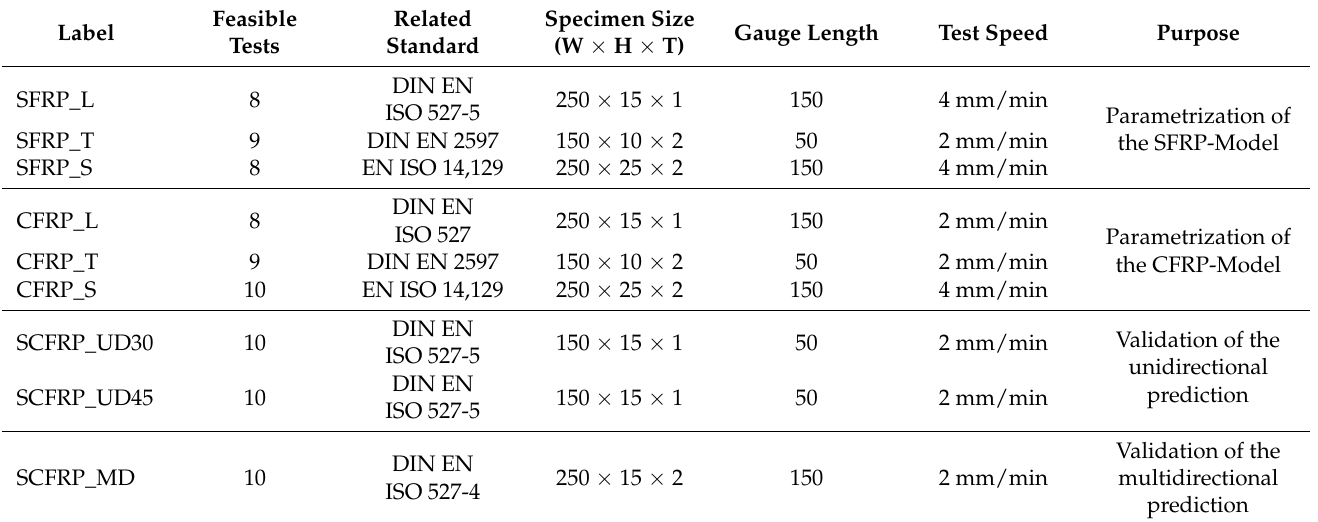
Table 2. Scope of testing as well as related standards, specimen geometries and testing parameters.